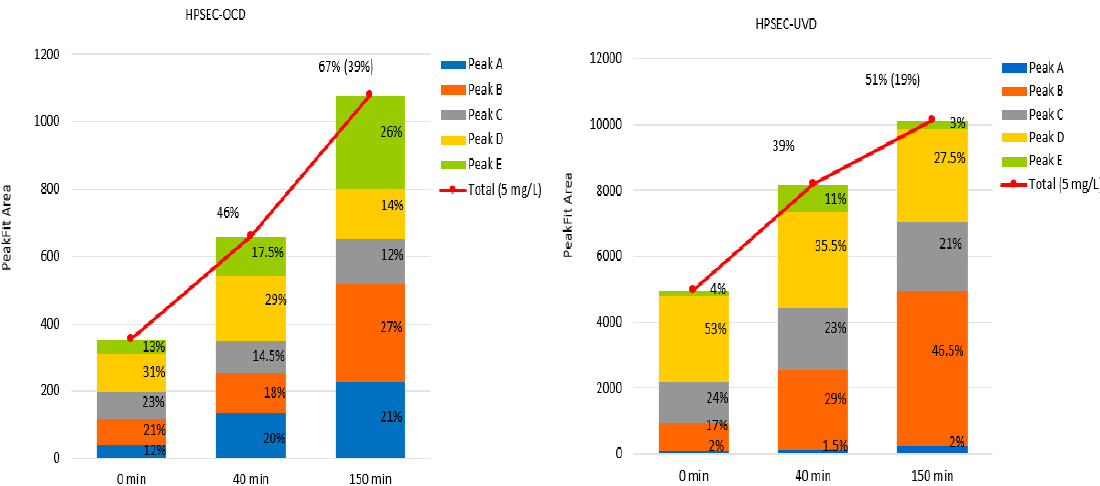
Fig. 3: Area percentage of organic fraction distribution during the bionet expressed by (a) HPSEC-OCD and (b) HPSEC-UVD with peakfitting software